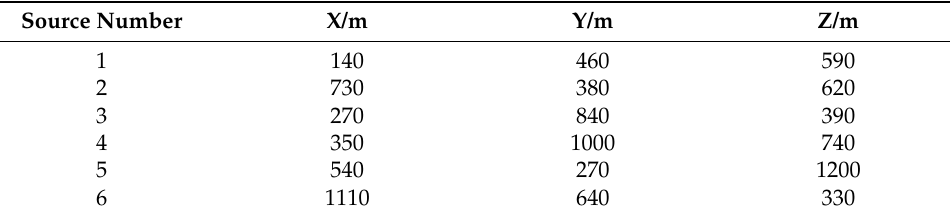
Table 3. 3D coordinates of each source point.